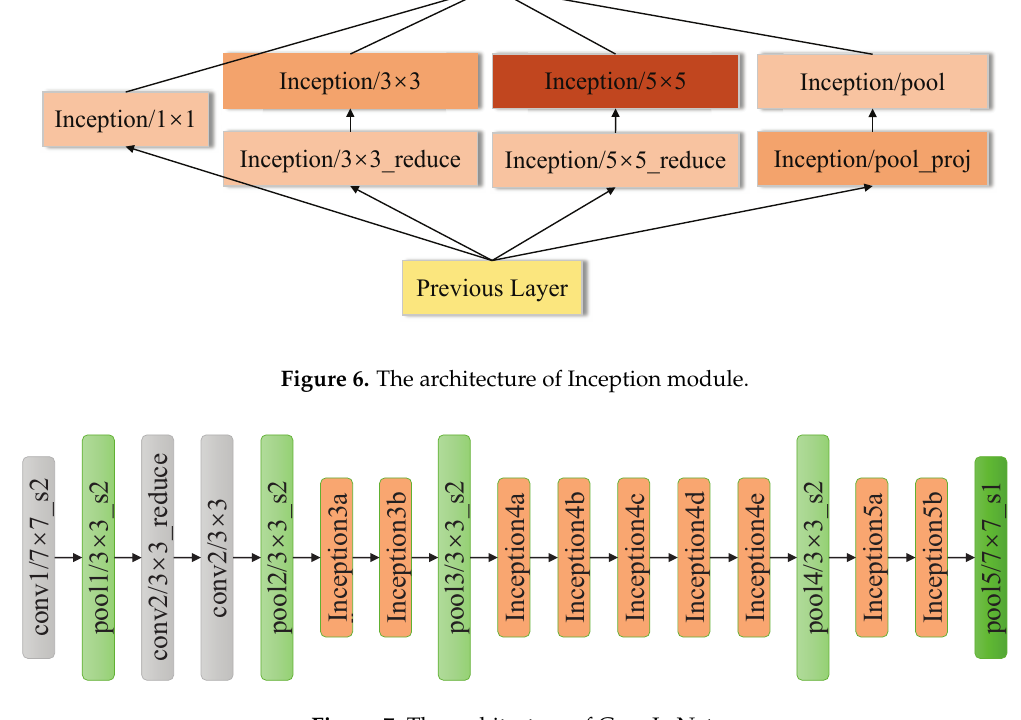
Figure 7. The architecture of GoogLeNet.